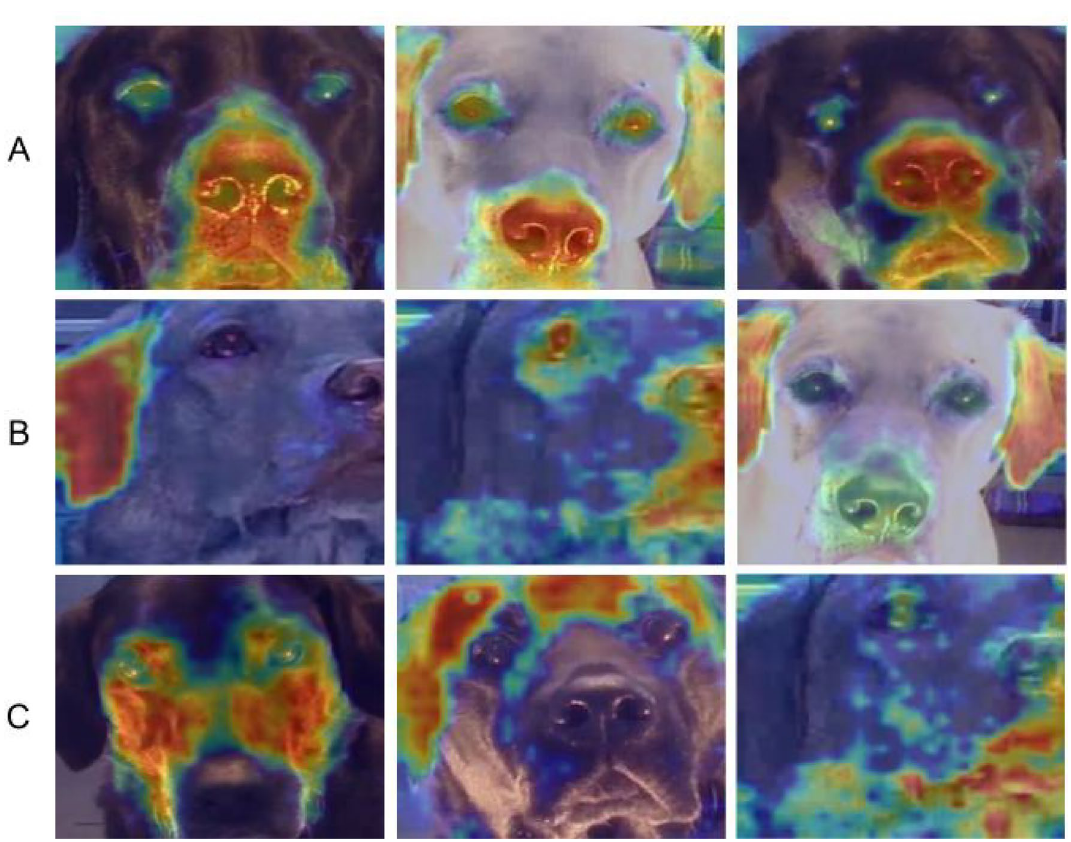
Figure 8. Exploring frames with no DogFACS variables correctly classified by the DNN. Category ( A ) focus mainly on nose-mouth area; Category ( B ) focus on other facial parts; Category ( C ) focus is blurry and not